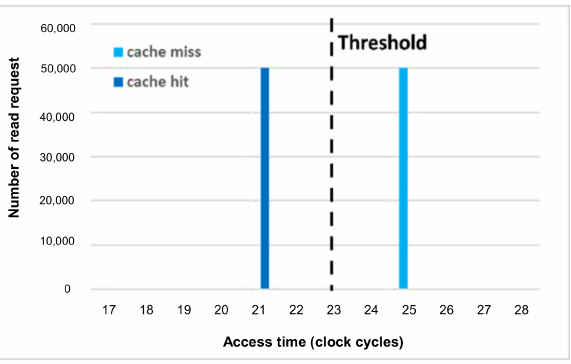
Figure 7. Histogram of cache miss and hit of a consistent read request (master interface frequency = 250